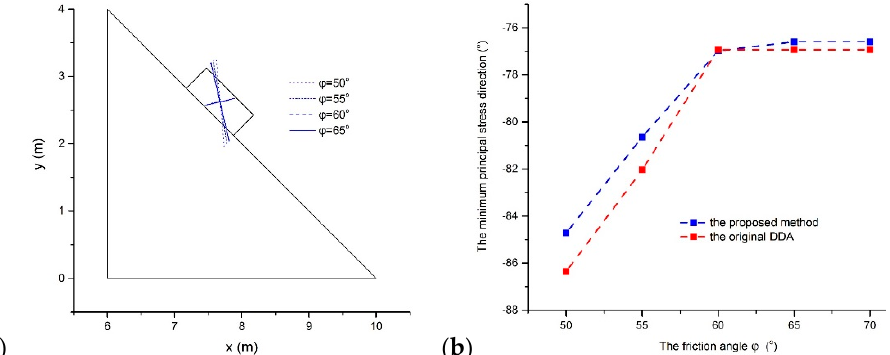
Figure 8. ( a ) The variations in minimum principal stress direction with the friction angles and ( b ) the difference in minimum principal stress direction of the two methods.